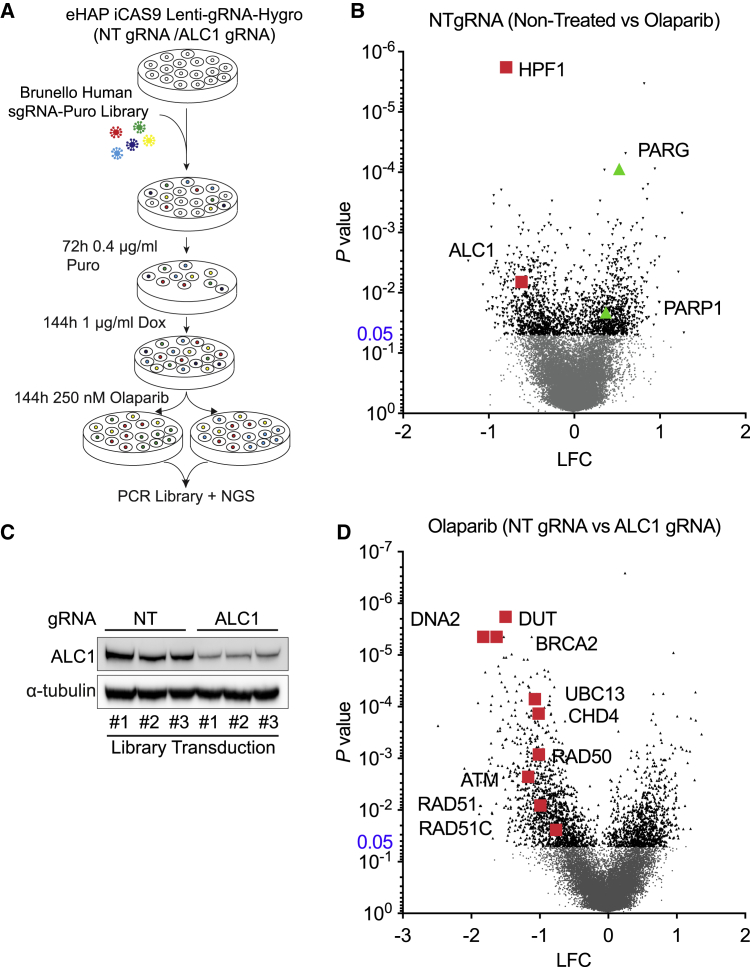
CRISPR screens identify novel synthetic lethalities with ALC1 deficiency(A) Schematic of screening pipeline.(B) Volcano plot of p value versus log-fold change (LFC), iCAS9 eHAP NT gRNA non-treated versus NT gRNA + 250 nM Olaparib.(C) Immunoblot of WCEs in eHAP iCAS9 NT gRNA and ALC1 gRNA from 3 independent biological replicates following 144 h Dox, probed for ALC1; α-tubulin was used as a loading control.(D) Volcano plot of p value versus LFC, iCAS9 eHAP NT gRNA + 250nM Olaparib versus ALC1 gRNA + 250 nM Olaparib.